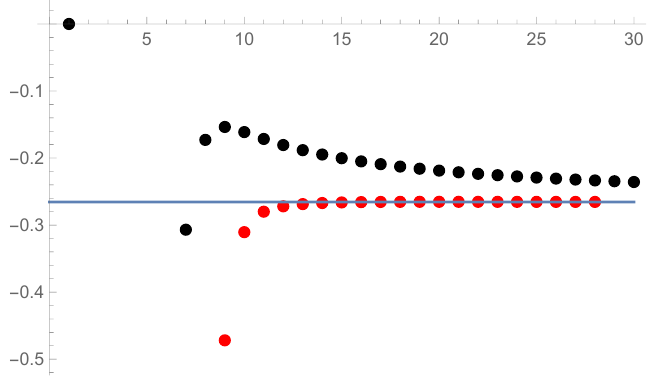
( 2 ) , defined in (cid:96)